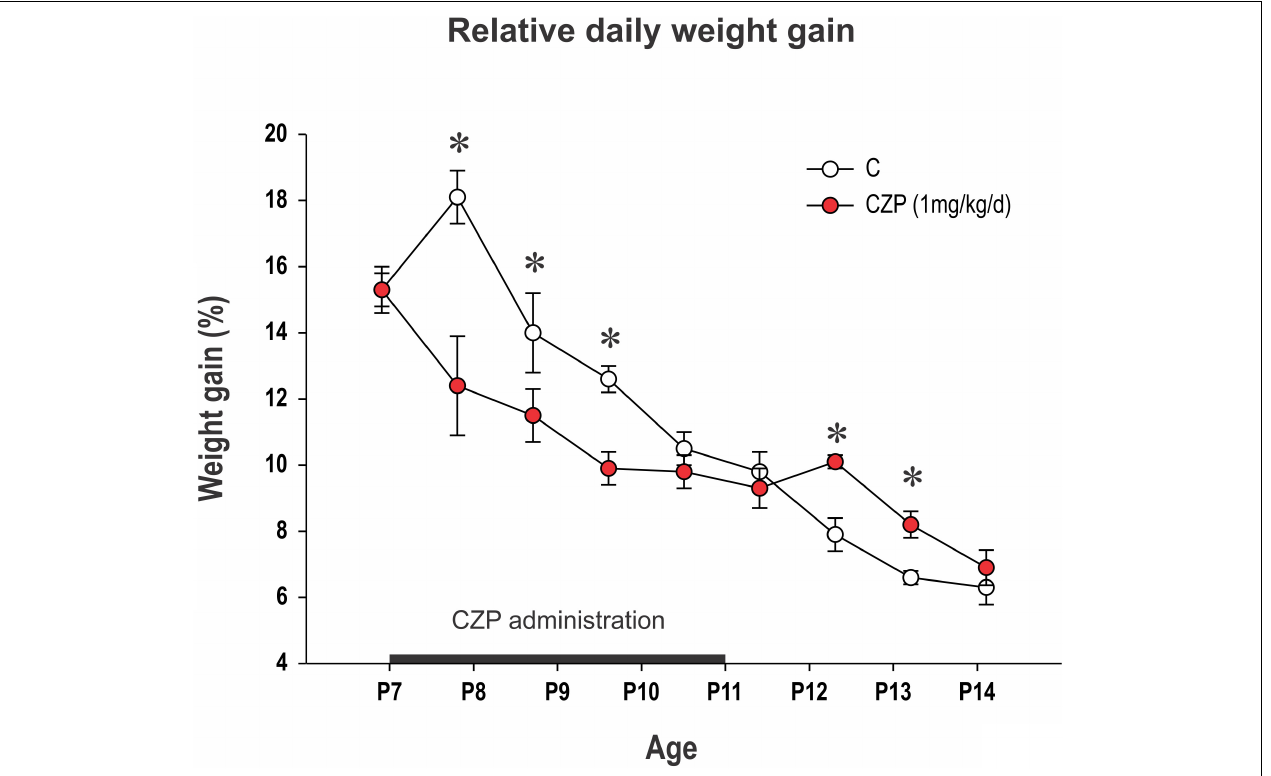
FIGURE 1 | Relative daily weight gain between P7 and P14. Body weight at P6 was normalized to 100% and differences in relative body weight between two consecutive days is presented ( y -axis). The x -axis shows age. CZP (1 mg/kg/day) was administered for five consecutive days beginning at P7 (black line on the x -axis). Data are presented as means ± SEM. Controls (empty circles) gained 10.5–18.1% of their body weight daily. CZP animals (red circles) gained significantly less weight up to the fourth day of administration. Asterisks denote significant differences compared to controls. C, controls; CZP, clonazepam-treated